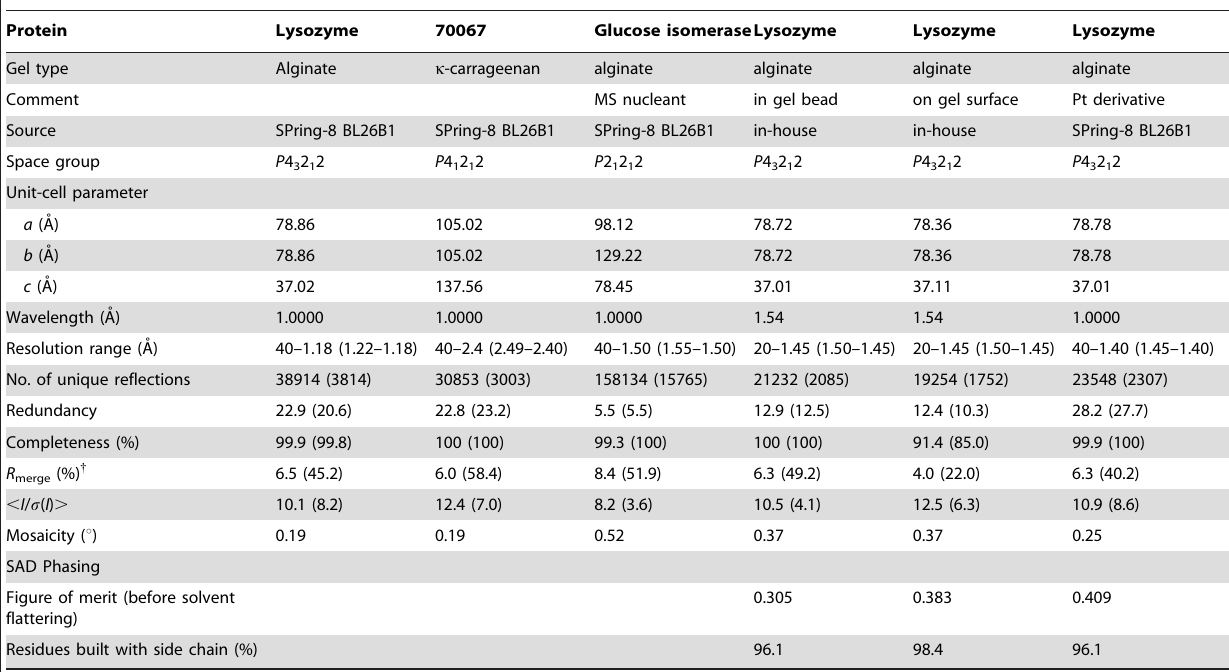
Table 1. Data-collection statistics.